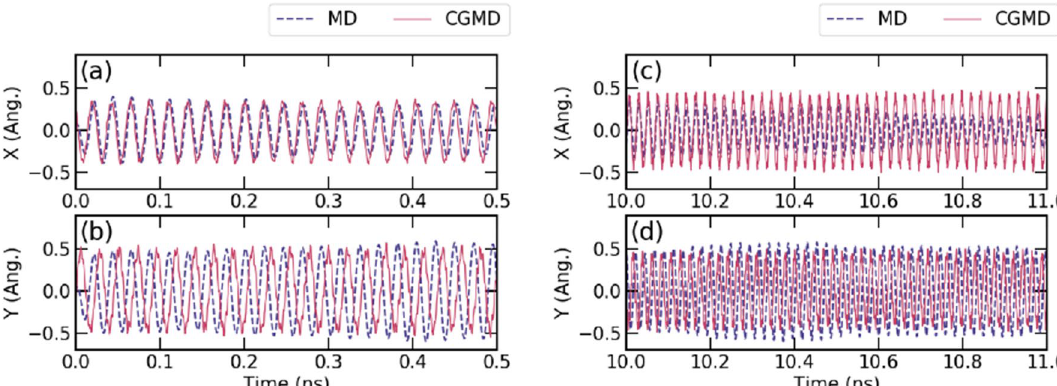
Figure 4. Initial trajectory of the SWCNTs calculated from MD and strain CGMD. The blue line shows the MD simulation results, and the red line shows the strain CGMD results. Strain CGMD obtains its initial data from the MD simulation, and there is no further compensation during the calculation process: ( a ), ( b ) displacements of the SWCNT tip along the x and y axes for the initial 0.5 ns, ( c ) and ( d ) displacements along x and y for 1 ns after 10